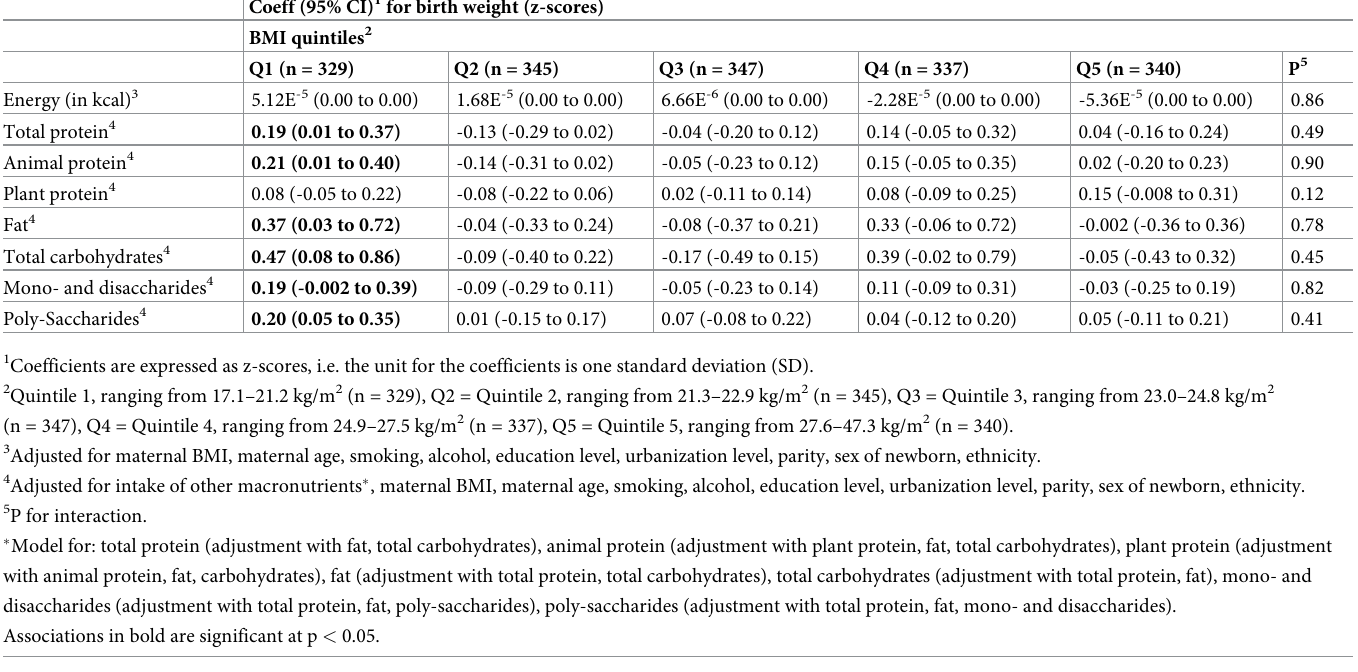
Table 3. Linear regression analysis of macronutrient intake in relation to birth weight in quintiles of BMI (n = 1698, 100%). Coeff (95% CI) 1 for birth weight